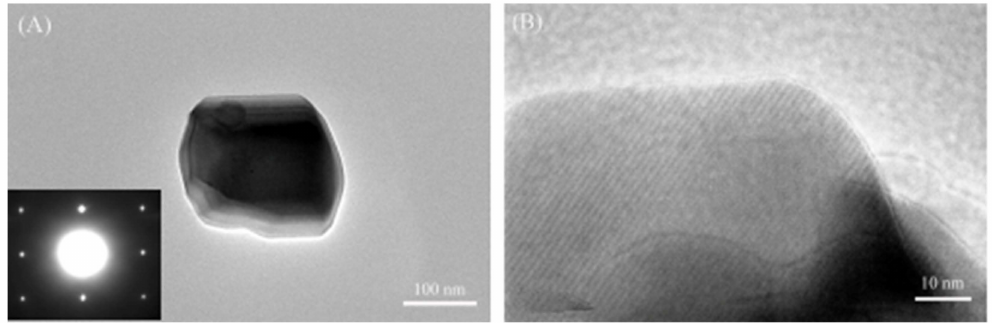
Figure 4. ( A ) Transmission electron microscopy, ( B ) high-resolution transmission electron microscopy image of a typicalSi 3 N 4 particle obtained at1300 ◦ C under NH 3 atmospherewith 4 wt% of CaF 2